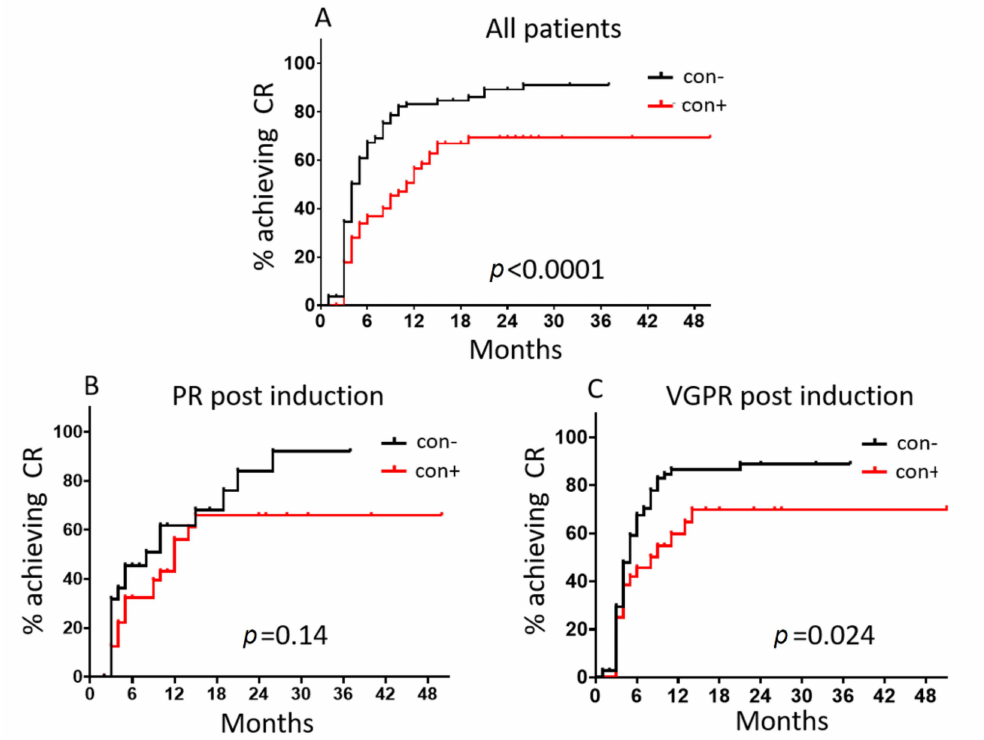
Figure 3. Time to CR achievement post ASCT according to graft contamination status for ( A ) all patients enrolled in the study ( n = 199), ( B ) patients who achieved PR post induction ( n = 61) and ( C ) patients who achieved VGPR post induction ( n = 109). con+, contaminated graft samples; con − , uncontaminated graft